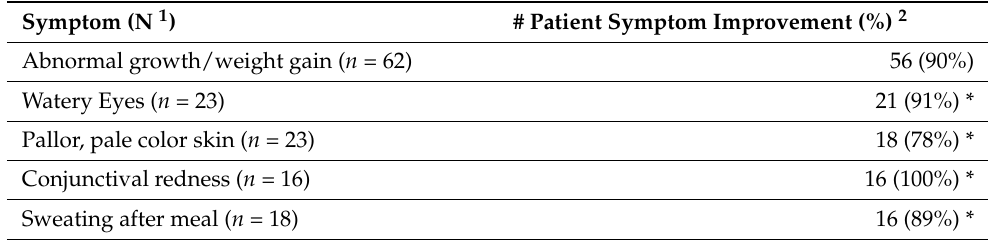
Table 5. Distribution of other symptoms in infants ≤ 6 months of age with diagnosed or sus- pected